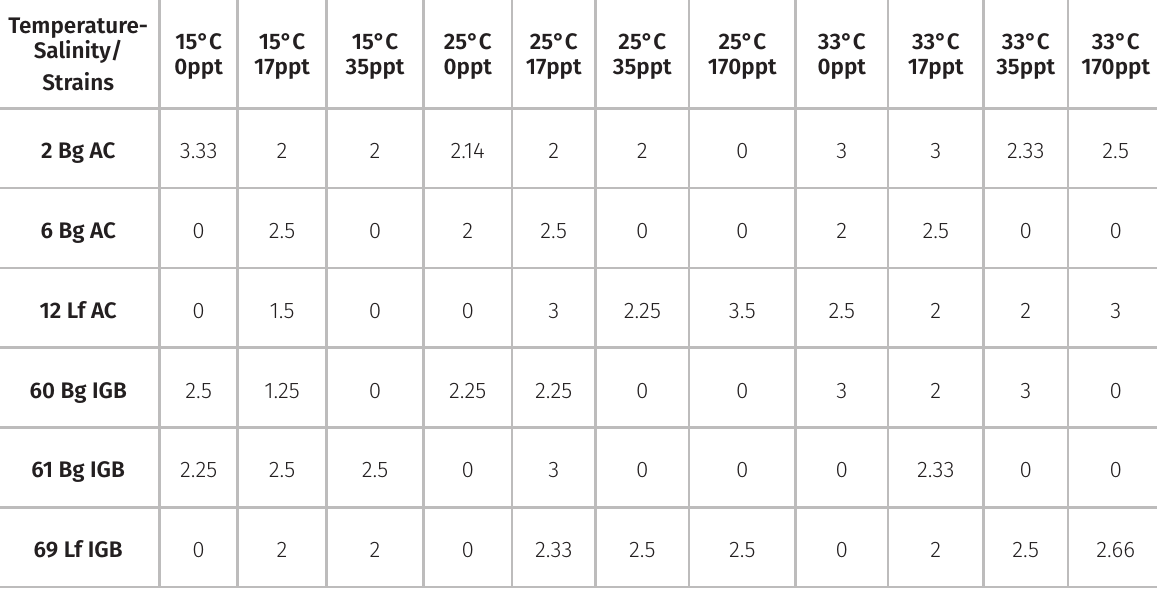
Table II. Cellulolytic activity (EI) presented by the strains isolated from Bankia gouldi (Bg) and Lyrodus floridanus (Lf) collected in Praia Grande - Arraial do Cabo (AC) and Ponta Leste - Ilha Grande Bay (IGB) at different temperatures (15, 25 and 33°C) and salinities (0, 17, 35 and 170 ppt of salt). Temperature-